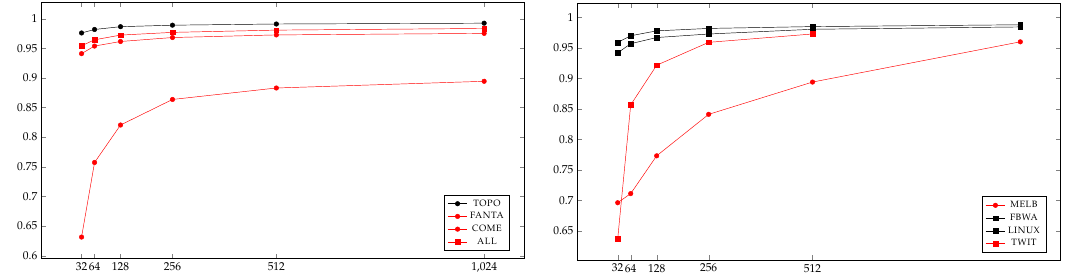
Figure 6. Average Kendall’s τ values for undirected (left) and directed (right) graphs as a function of the sample size h : the average Kendall’s τ of APX h (over 50 experiments) is computed by referring − to the ranking computed by EXACT , except for the TWIT graph plot, where we refer to the ranking computed by APX -1024 (for this reason, its plot stops at h =